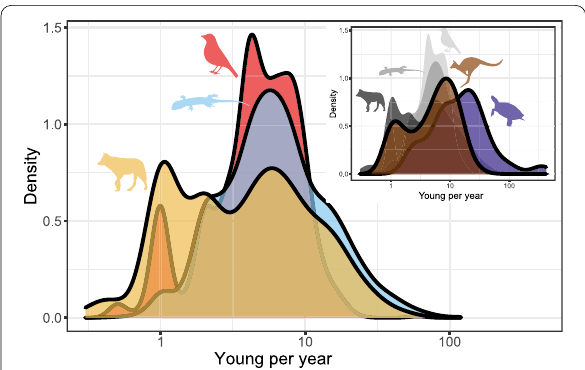
Fig. 11 Young per year. Red: birds; blue: squamates; purple: turtles; yellow: placental mammals; brown: marsupial mammals. Note that the x axis is log 10